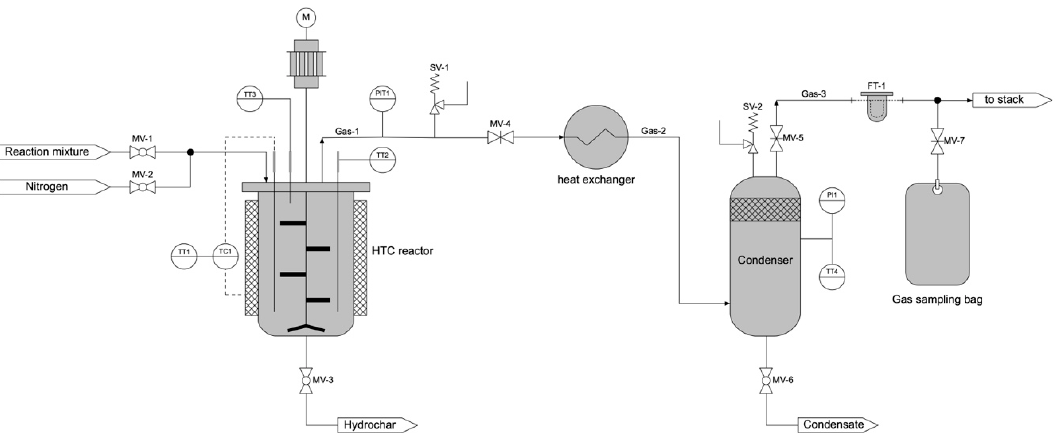
Figure 2. Sketch of the hydrothermal carbonization (HTC) reactor.